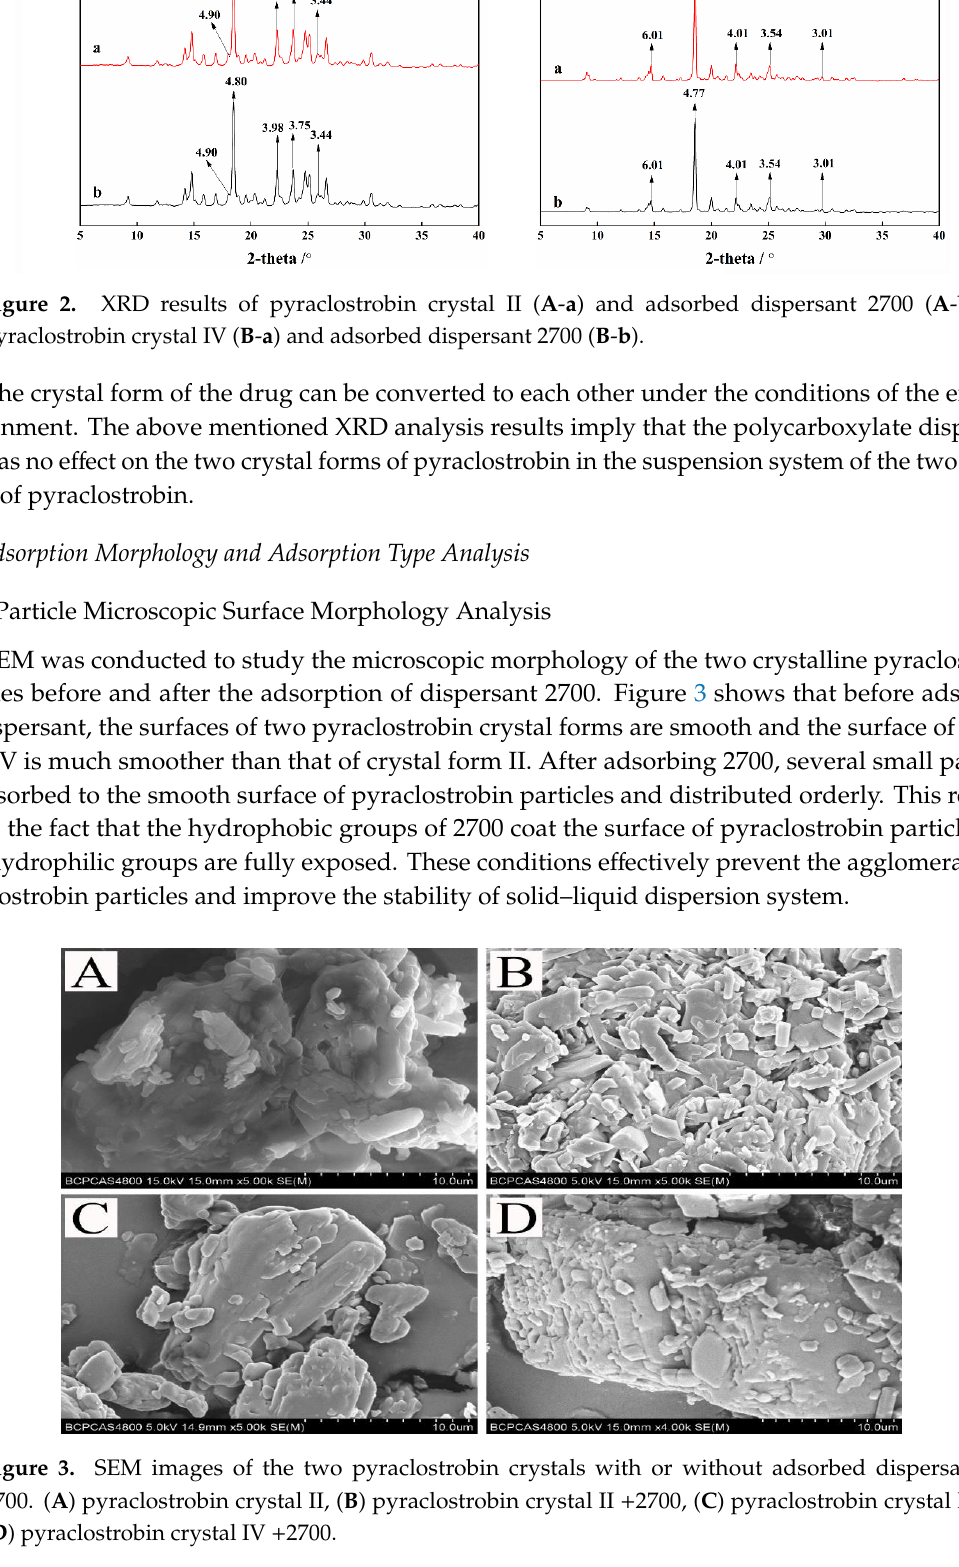
Figure 3. SEM images of the two pyraclostrobin crystals with or without adsorbed dispersant 2700. ( A ) pyraclostrobin crystal II, ( B ) pyraclostrobin crystal II +2700, ( C ) pyraclostrobin crystal IV, ( D ) pyraclostrobin crystal IV +2700.